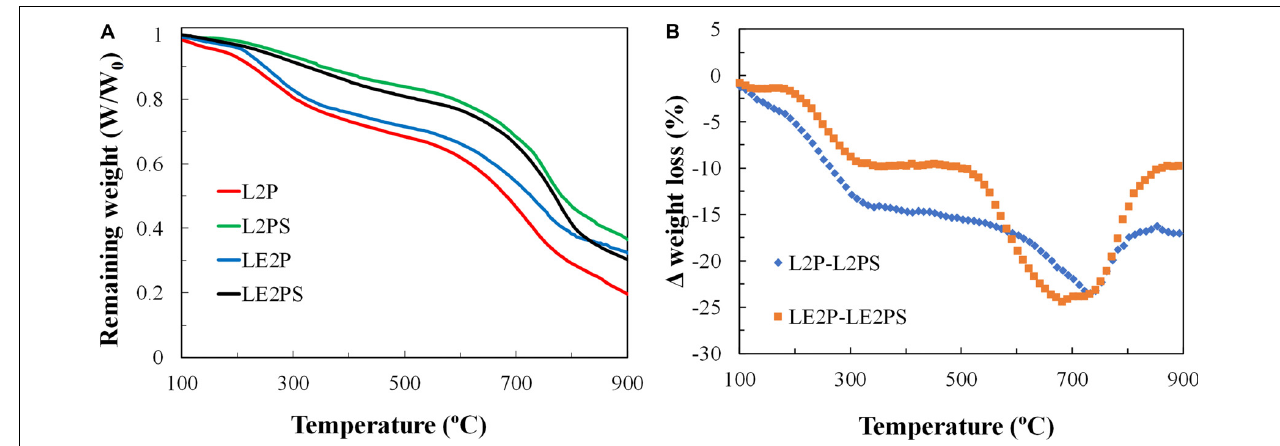
FIGURE 4 | (A) Thermogravimetric analysis in inert atmosphere for different lignin-derived samples; (B) Weight loss differences during TG analyses between the non-treated and low temperature oxidized (air) treated samples.